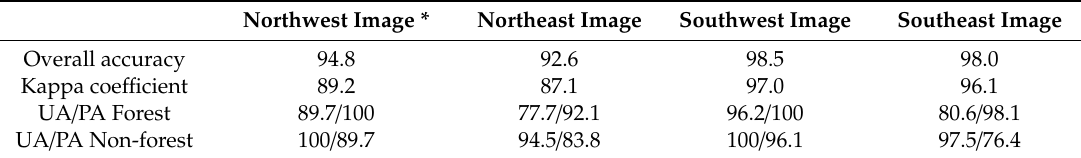
Figure 4. Variability of F1 value for the forest cover classification based on the combination of different variables. The box plot indicates outliers, first quartile, median, third quartile and maximum values. Table 1. The accuracy of the forest cover classification based on the combination of Sentinel-2 bands at 10 m and 20 m spatial resolution and DEM, * indicates image used for the parametrisation of the classification model; UA: user’s accuracy, PA: producer’s